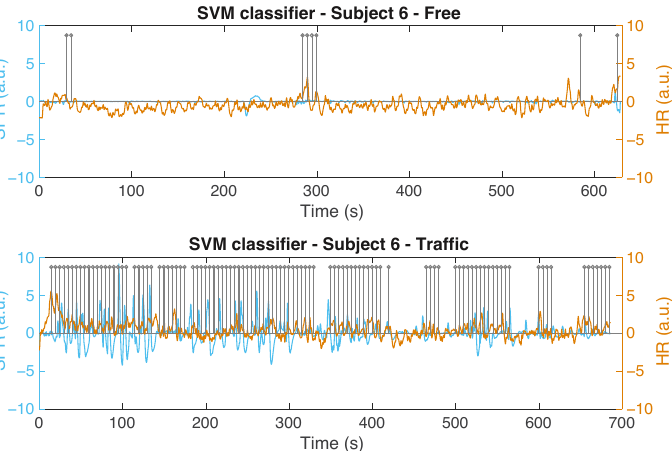
Figure 10. The output of the SVM classifier for Subject 6 in both scenarios: without traffic ( top ) and with traffic ( bottom